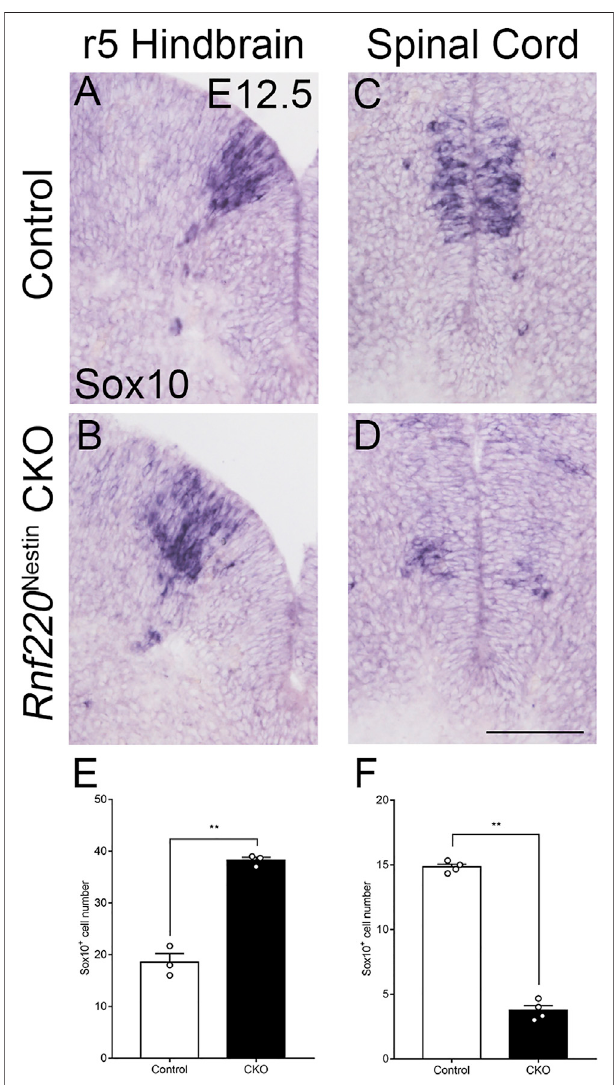
FIGURE6| OPCsareIncreasedintheHindbrainbutnottheSpinalCord of Rnf220 Nestin CKO Embryos. (A – D) In situ hybridization for Sox10 at E12.5. At the r5-derived level ofthe hindbrain, the number of the OPCs are increased in Rnf220 Nestin CKO embryos (B) compared with controls (A) , whereas the number is decreased in CKO (D) compared with that of the control (C) in the spinal cord. Scale bar, 100 μ m (D) ; also applies to (A – C) . (E) Quanti fi cationof Sox10 + cellsofther5hindbrainatE12.5. (F) Quanti fi cationof Sox10 + cells of the spinal cord at E12.5. Data are expressed by mean ± SEM. Student ’ s t -test (n ≥ 3 for each). **, p < 0.01.